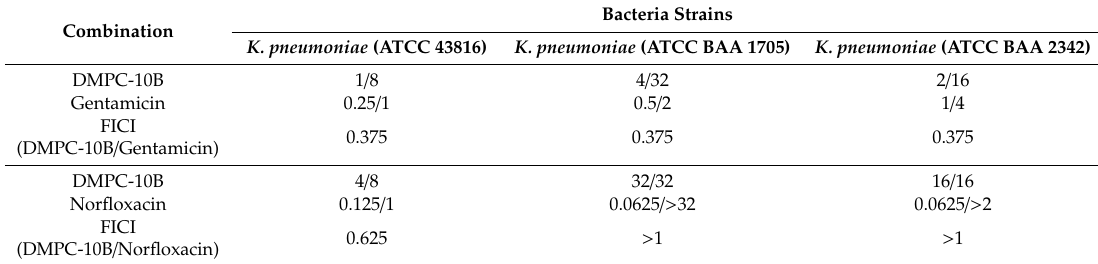
Table 3. Synergistic e ff ect of DMPC-10B with gentamicin and norfloxacin against the growth